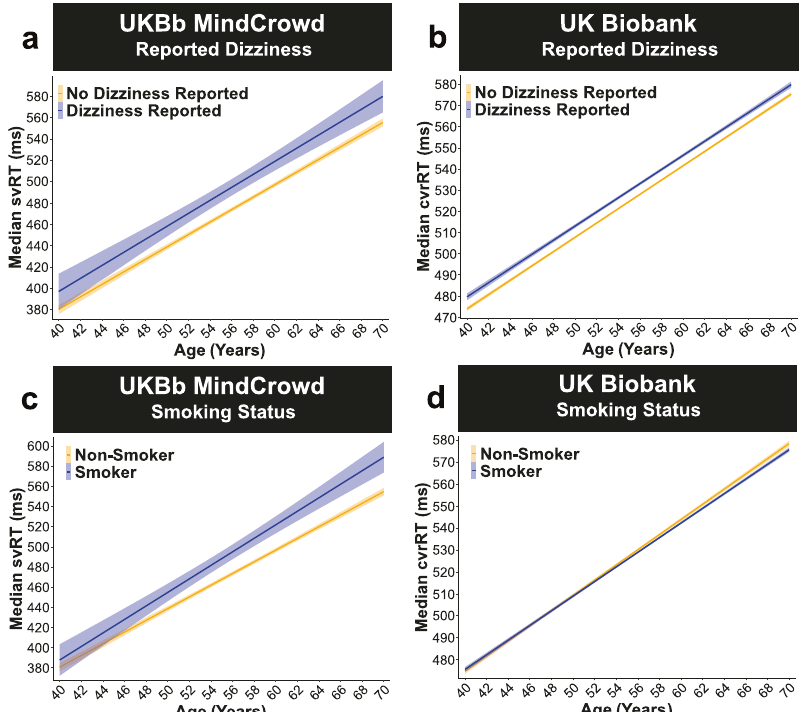
Fig. 7 UK Biobank: reported dizziness and smoking status. UKBb MindCrowd and UK Biobank analysis (ages 40 – 70) of visual reaction time (RT). a – b Reported Dizziness was associated with lengthened visual RT. a UKBb MindCrowd linear model fi ts (line fi ll ±95% CI) of median simple visual RT (svRT) from young to old Age with lines split by Reported Dizziness. b UK Biobank linear model fi ts (line fi ll ±95% CI) of median complex visual recognition RT (cvrRT) from young to old Age with lines split by Reported Dizziness. UKBb MindCrowd svRT ( β Dizzy = 12.13, p Dizzy = 2.52E − 03, Reported Dizziness Reported n = 2543, No Reported Dizziness Reported n = 37,252) and UK Biobank cvrRT ( β Dizzy = 3.21, p Dizzy = 3.71E − 14, Reported Dizziness Reported n = 42,210, No Reported Dizziness Reported n = 116,035) were lengthened if participants Reported Dizziness. c – d Smoking Status was associated with lengthened svRT in UKBb MindCrowd, but not cvrRT in the UK Biobank. c UKBb MindCrowd linear model fi ts (line fi ll ±95% CI) of median svRT from young to old Age with lines split by Smoking Status. Compared to non-smokers, smokers were associated with longer svRTs ( β Smoke = 10.18, p Smoke = 0.01, Smoker n = 2783, Non-Smoker n = 37,012). d UK Biobank linear model fi ts (line fi ll ±95% CI) of median cvrRT from young to old Age with lines split by Smoking Status. An association between Smoking Status and cvrRT was not found in the UK Biobank ( β Smoke = 0.47, p Smoke = 0.22, Smoker n = 91,312, Non- Smoker n =